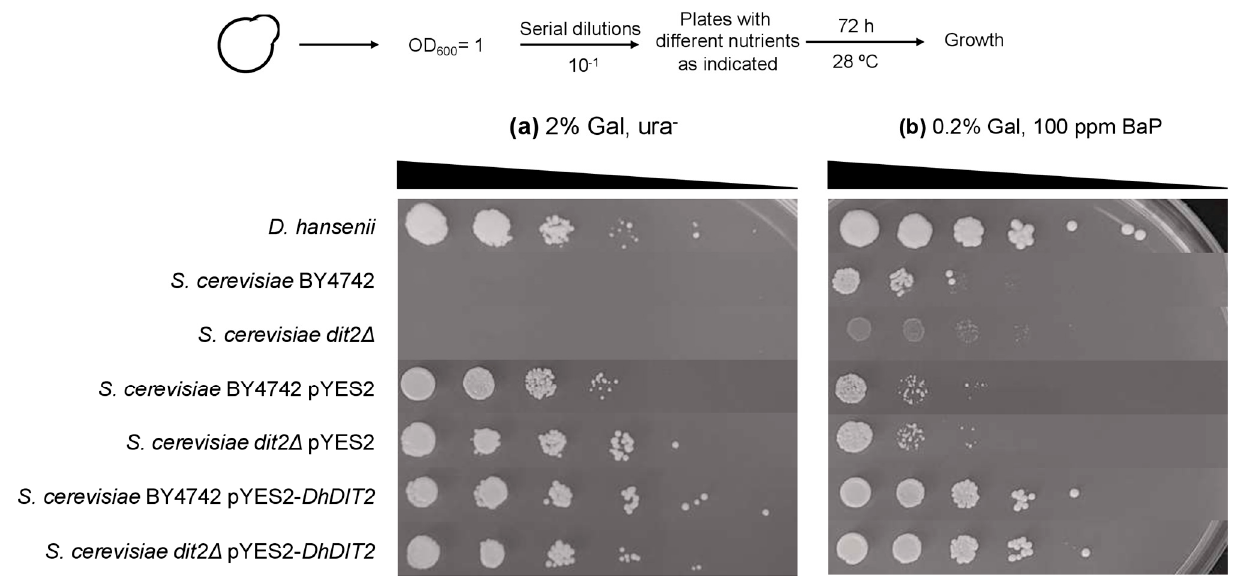
Figure 7. Effect of BaP on the growth shown by the wild-type S. cerevisiae and D. hansenii , as well as the S. cerevisiae dit2 Δ mutant transformed with the DhDIT2 gene. The indicated strains were grown overnight in either liquid YNBG or YNBGal media and the cultures were adjusted to OD 600 = 1.0. Aliquots of 10-fold serial dilutions were spotted in YNB medium containing 2% galactose without uracil ( a ) or in YNB medium containing 0.2% galactose supplemented with 100 ppm BaP ( b ). The plates were incubated at 28 °C for 72 h and photographed afterwards. A representative image of three independent experiments is shown.